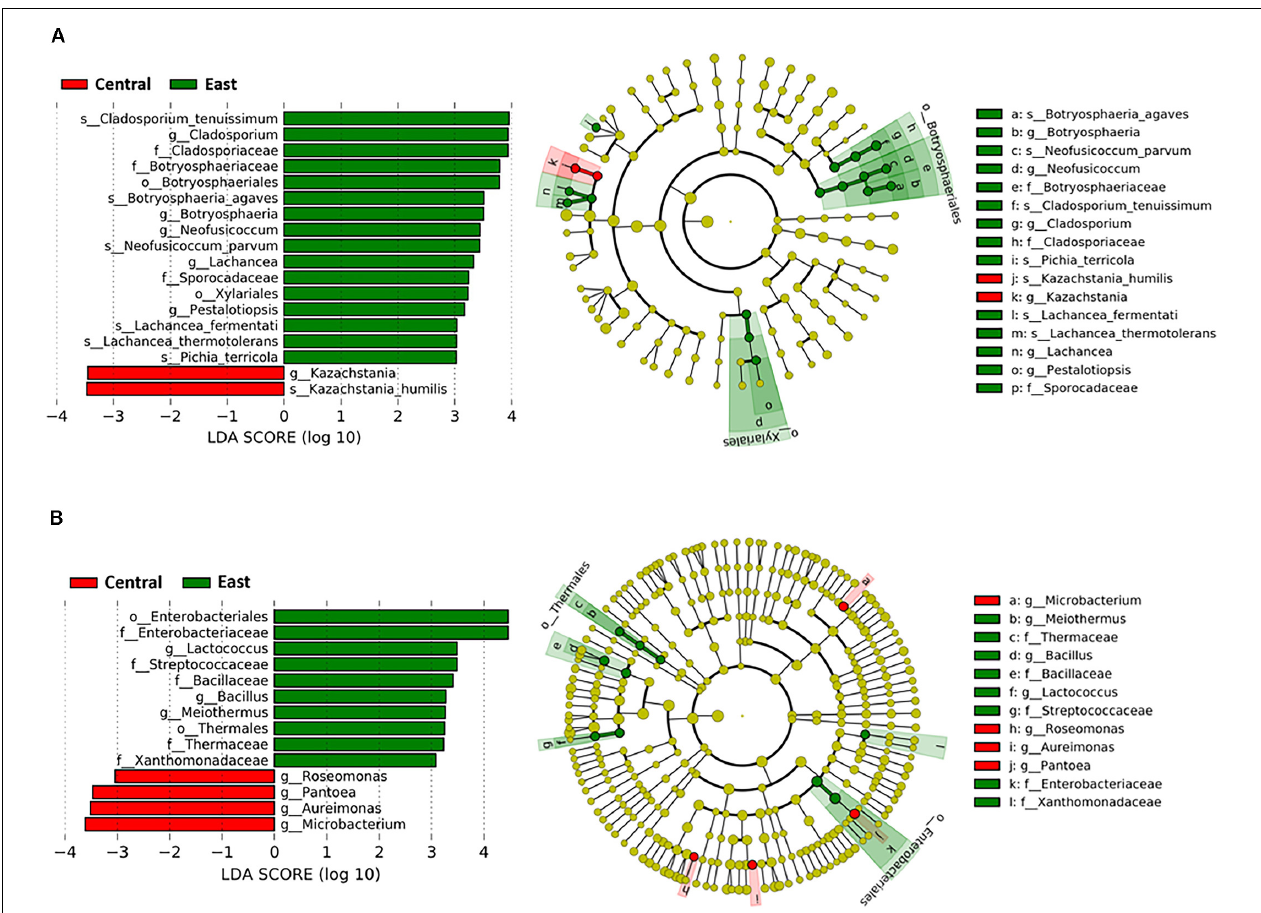
FIGURE 4 | Taxa that discriminated between samples from the Central and East regions throughout Chambourcin fermentation. Linear discriminant analysis with effect size (LEfSe) analyses were performed using microbial relative abundance data. Data shown are the log 10 linear discrimination analysis (LDA) scores following LEfSe analysis and the hierarchy of differential taxa visualized as cladograms for different taxonomic level comparisons between two regions for the (A) fungal, and (B) bacterial communities. A cut-off criterion of LDA scores > 3 and p -value < 0.05 was